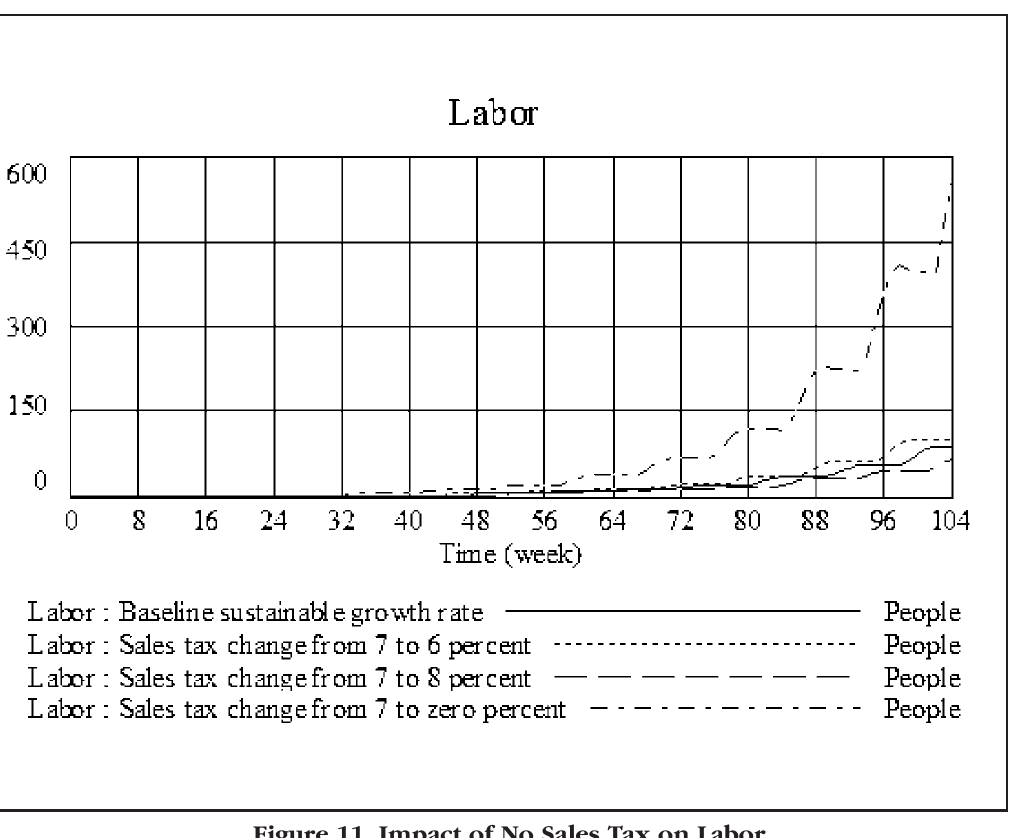
Figure 11. Impact of No Sales Tax on